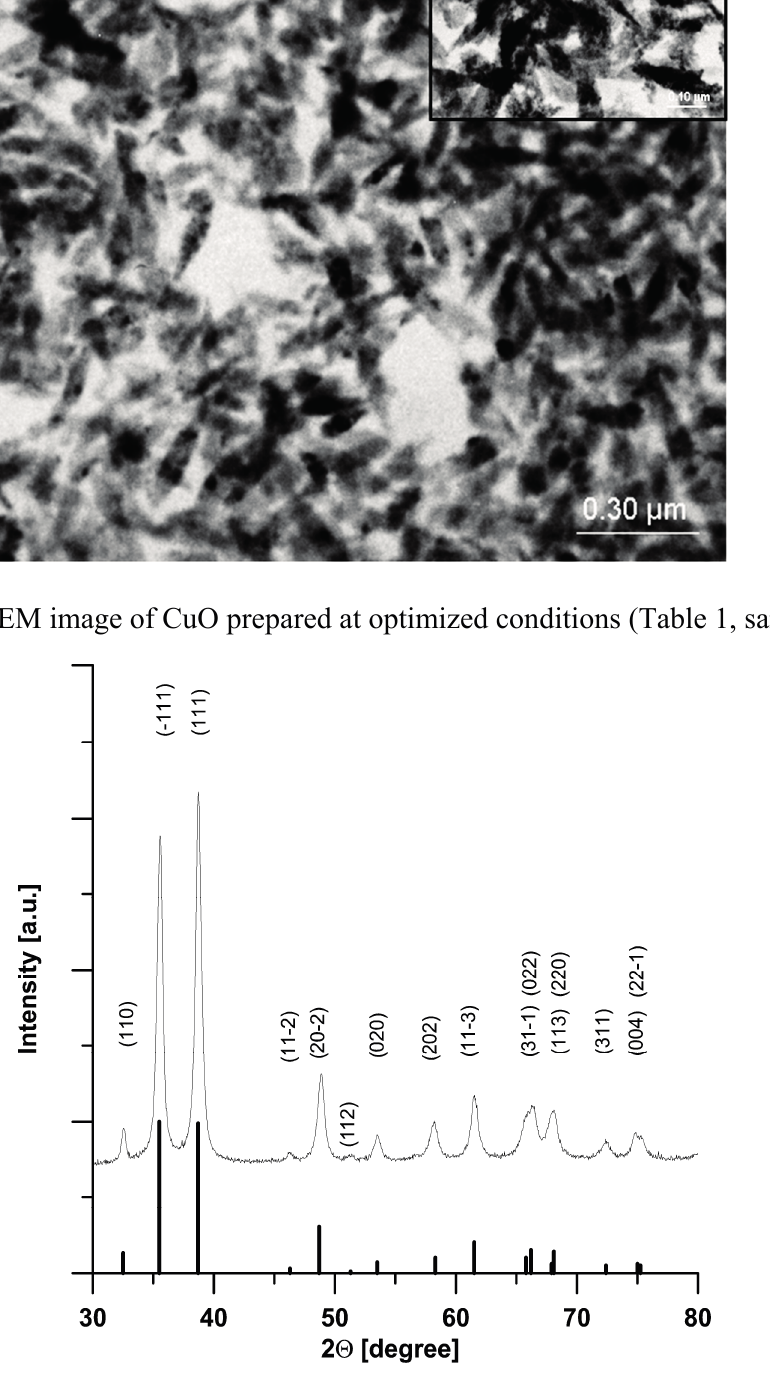
Figure 6. XRD pattern of the CuO sample (Table 1, sample